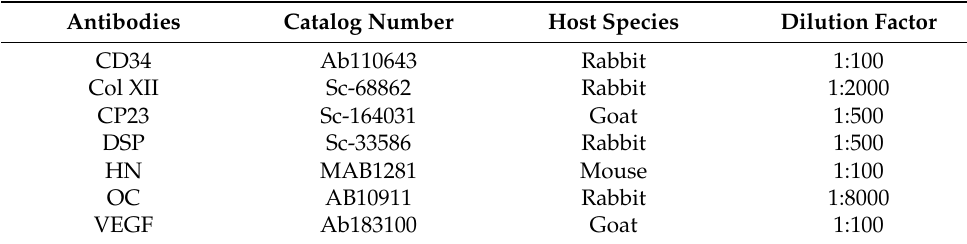
Table 1. Primary antibodies for